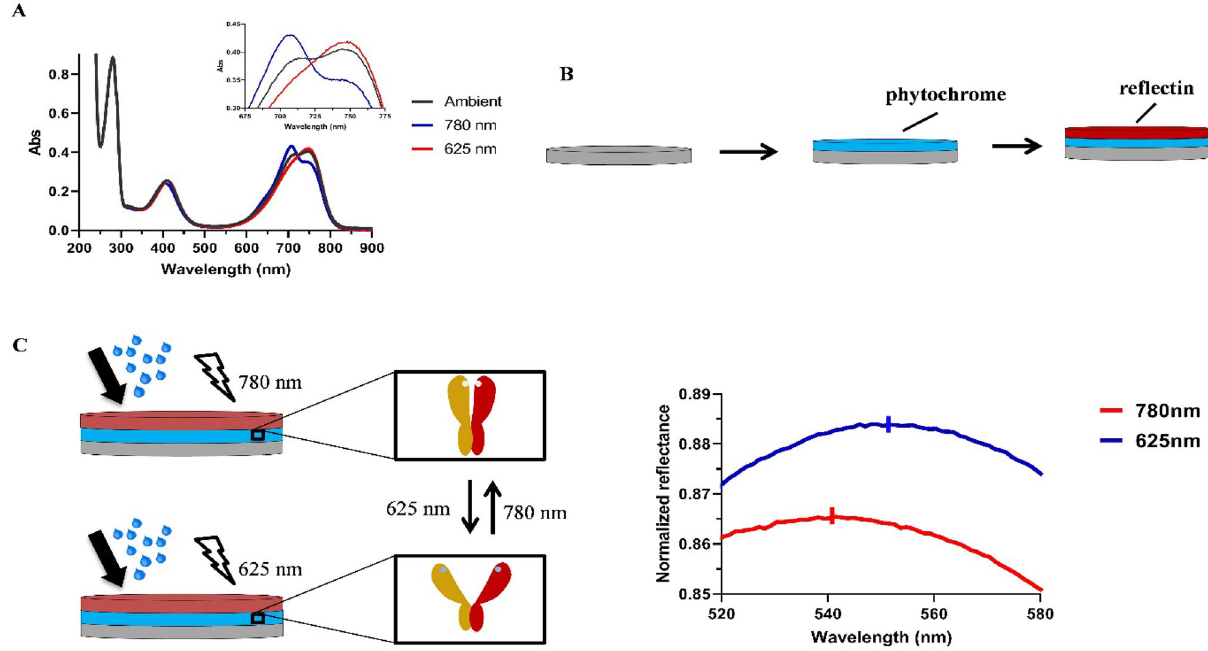
Figure 8. ( A ) UV/Vis spectra of A. fabrum phytochrome in H 2 O after being exposed to ambient, red (625 nm), and far- red (780 nm) light. ( B ) Schematic figure showing the integration of phytochromes into reflectin films using spin-coating. ( C ) Schematic figure showing proposed mechanism of phytochrome switching between ‘open’ and ‘closed’ states in response to activation, alongside the corresponding peak